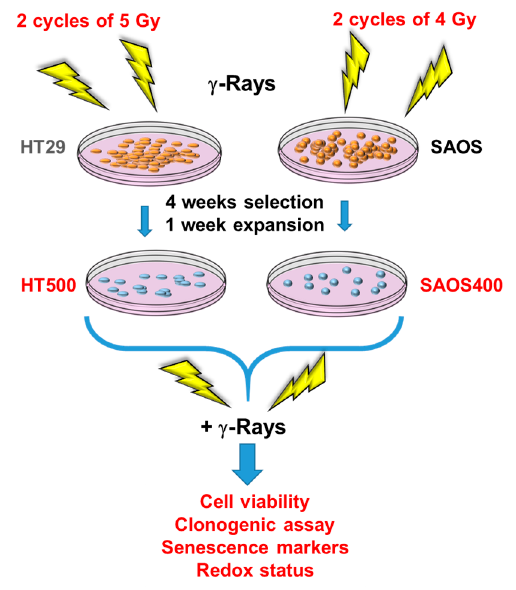
Figure 1. Scheme summarizing the procedures applied to obtain radio-resistant HT500 and SAOS400 cell lines from their parental HT29 and SAOS cells, respectively. cell lines from their parental HT29 and SAOS cells,